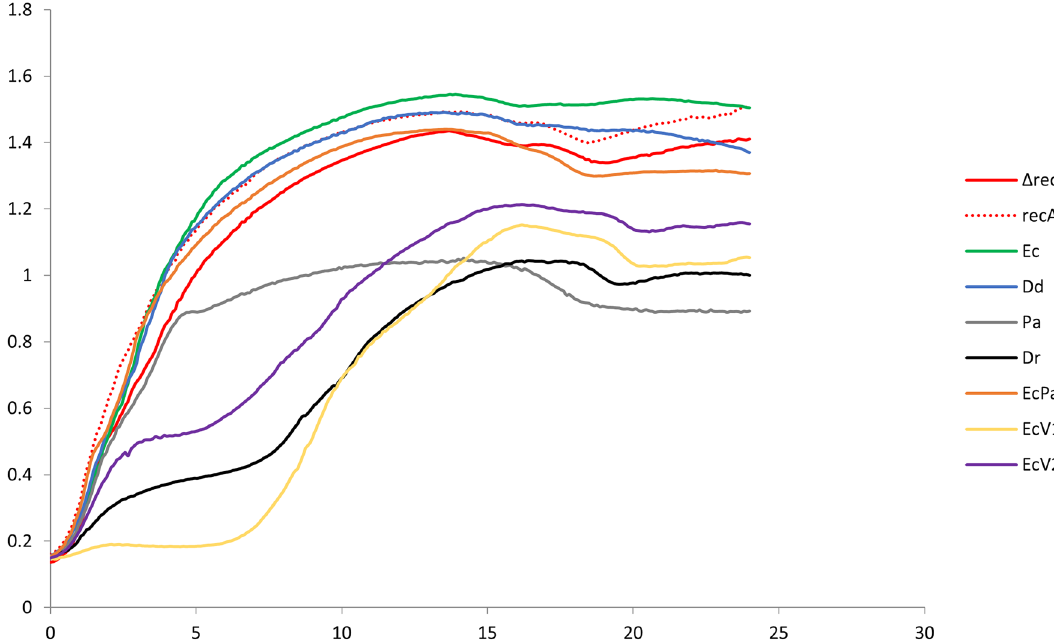
Figure 4. Growth curves of strains producing RecA variants. MG1655 nalR lacZΔP recA ::Cm cells transformed with pQE-80L plasmid derivatives containing each of the seven recA variants induced by 1 mM IPTG were cultured at 37 °C in microplate and the growth was analysed by measuring the OD600 with Tecan Spark for 24 h. Triplicates were performed. MG1655 nalR lacZΔP RecA + strain (red dotted curve), ΔrecA strain (red curve), ∆recA strains producing EcRecA (green curve), DdRecA (blue curve), PaRecA (grey curve), DrRecA (black curve), EcPa variant (orange curve), EcRecAV1 variant (yellow curve) or EcRecAV2 variant (violet curve) are